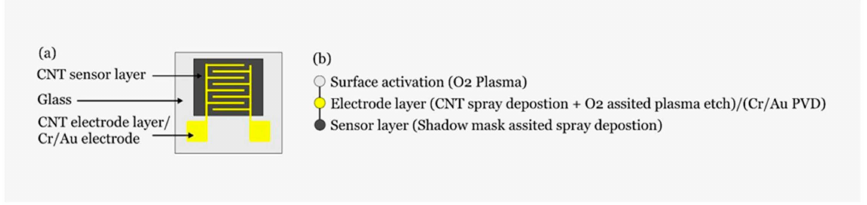
Figure 1. ( a ) Sensor schematic; ( b ) fabrication